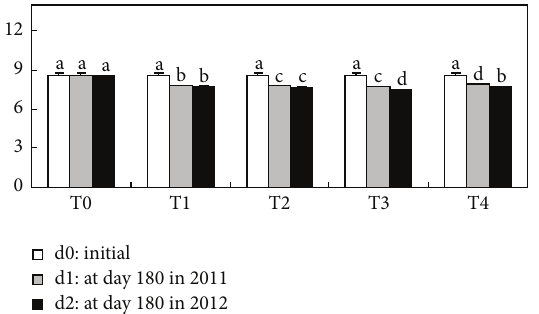
Figure 1: Effects of FGDB application on soil pH values for